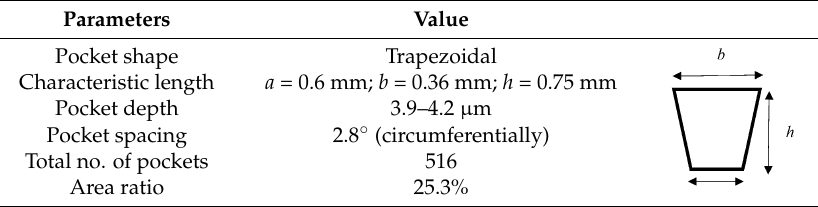
Figure 3. Image of pocketed compression ring [14]. Table 1. Geometric parameters of lasered pockets [14].